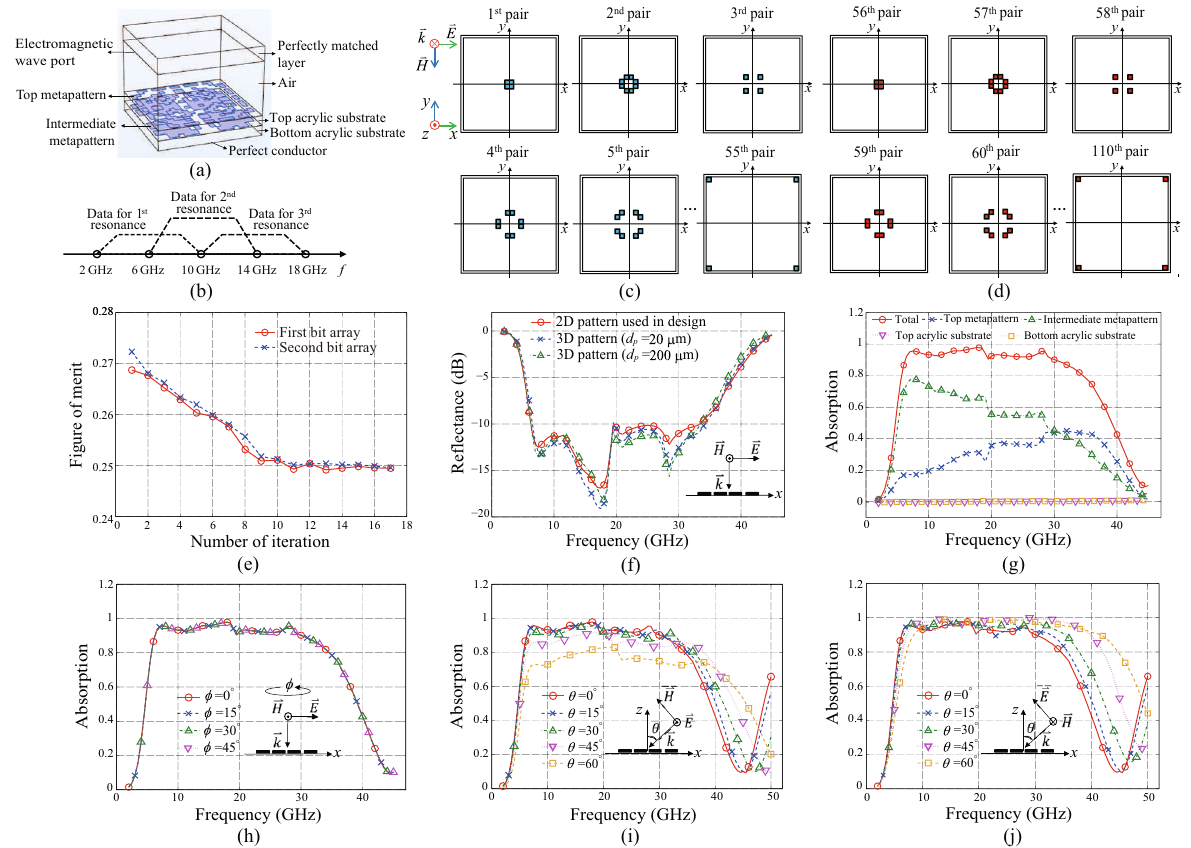
Figure 2. Schematics for designing optimal carbon metapatterns and simulation results of optimized metamaterial absorber. ( a ) Total structure and simulation setting. The side exterior boundaries of it are set to the periodic boundary condition. ( b ) Division of frequency domain into overlapping windows including three-points data. Combinations of pixel pairs for ( c ) top and ( d ) intermediate metapatterns. ( e ) Figure of merit vs number of iteration. ( f ) Simulated reflectances for normal incidence using 2D and 3D metapatterns. ( g ) Absorptions calculated at each part of the total structure and their total summation for normal incidence using 3D metapattern with d p = 200 µ m. ( h ) Absorptions calculated for horizontal rotations of TE polarization. Absorptions calculated for oblique incidences of ( i ) TE and ( j ) TM